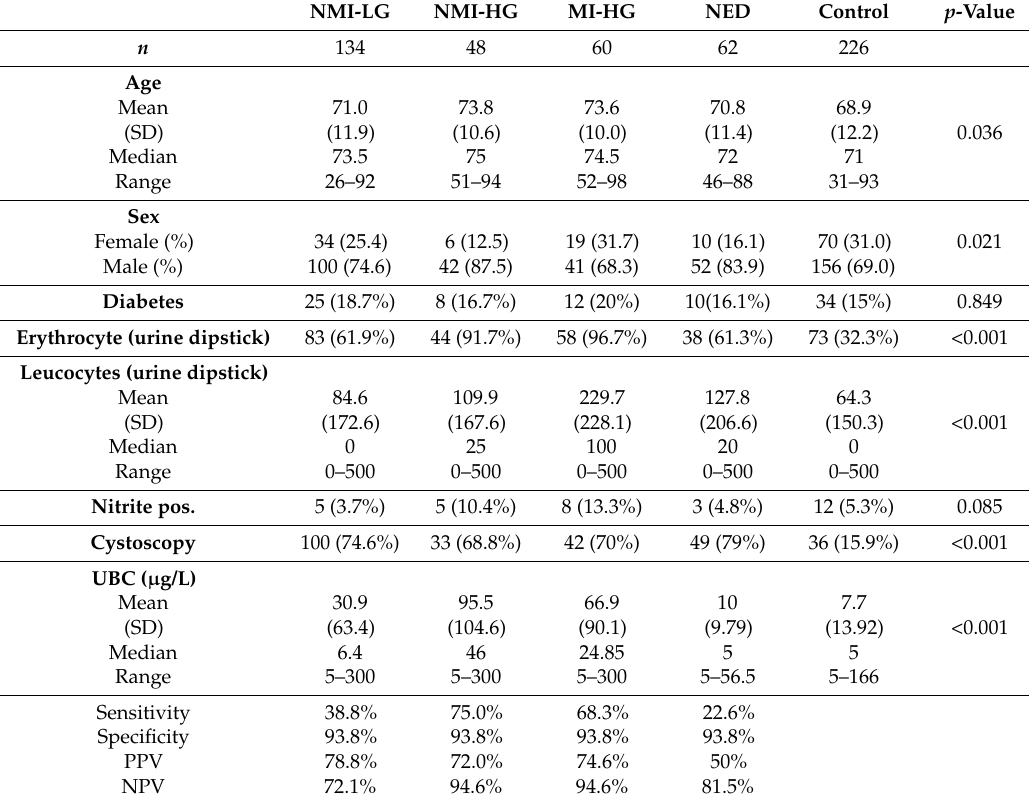
Table 1. Patient characteristics and results of UBC ® Rapid. Abbreviations: non-muscle-invasive